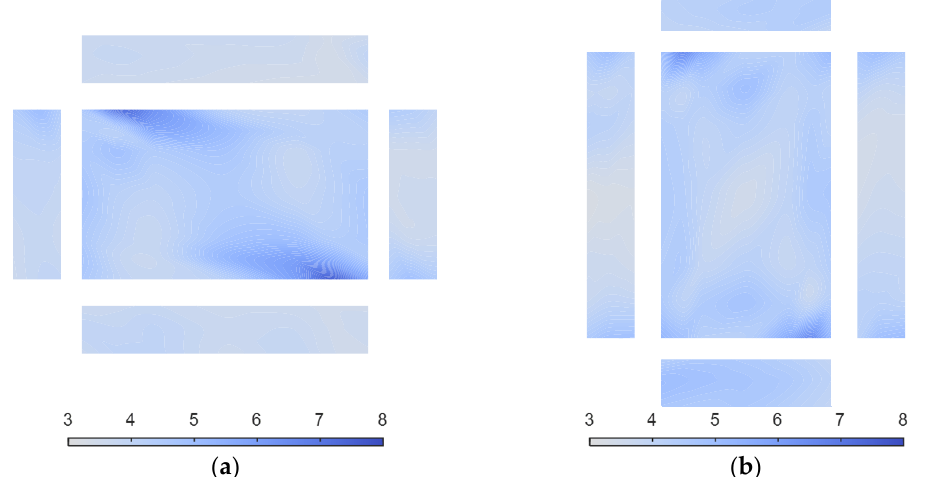
Figure 12. Contour maps of the maximum peak pressure coe ffi cients at each tap from x = − 3 r c to x = 3 r c . ( a ) θ = 0° and ( b ) θ = 90°.